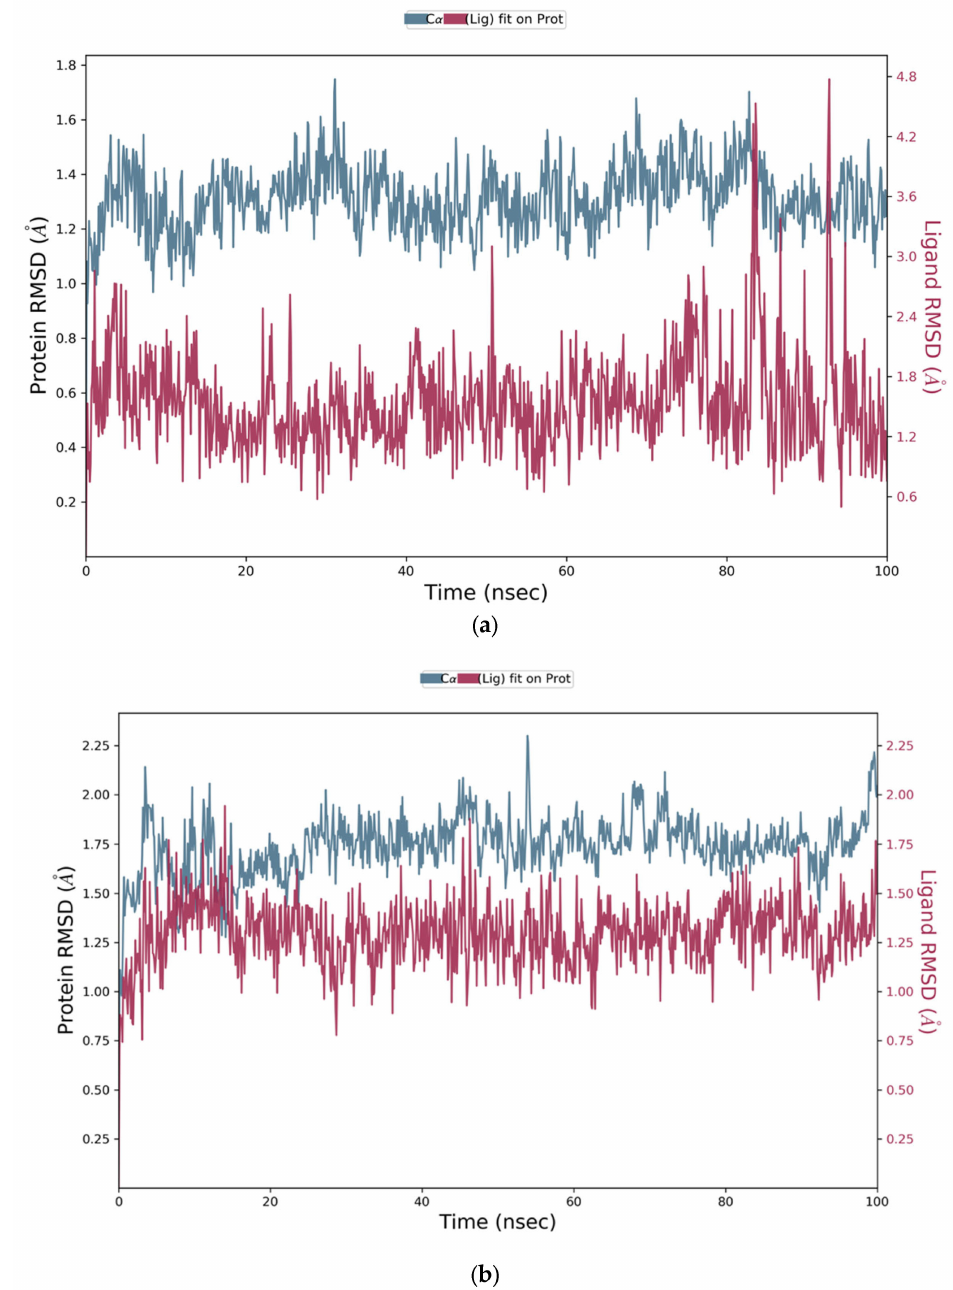
Figure 7. ( a ) Representation of Root Mean Square Deviation plot of Comp3 and NS2B-NS3 complex of ZIKV. ( b ) Root Mean Square Deviation plot of NS2B-NS3 complex of ZIKV PDB ID: 5LC0. Moreover, to examine individual amino acid residue fluctuation, the RMSF values for all the complexes were estimated. The RMSF values for the catalytic region of the NS2B-NS3 of all the complexes exhibited stability. There were no considerable fluctuations observed where the ligand binds with the protein. As compared to all residues, the residues Lys 1015, Gly 1016, and Glu 1017 expressed higher fluctuations. The calculated RMSF values are represented in Figures 8–11. The green vertical lines in the plots represent the interacting residues of NS2B-NS3 of Zika virus with their respective compounds. The residues where most of the compounds make interactions are SER 81- PHE 84, GLN 135-GLY 139, TRP 150-LYS 154, VAL 172-ASP 175, LEU 1128-THR 1134, and TYR 1150-TYR